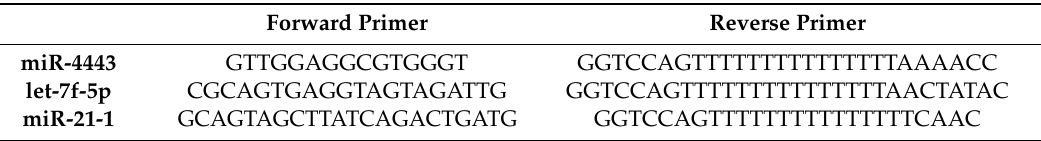
Table 1. qPCR primers used (see